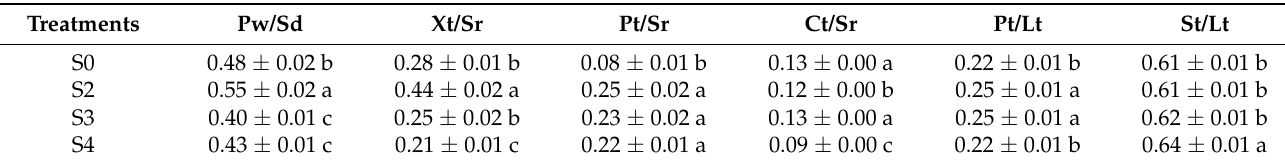
Table 6. Effects of salinity stress on the anatomical structure of organs in C. elegans seedlings. S0, S2, S3, and S4 indicate control, 0.2%, 0.3%, and 0.4% salt concentration treatments, respectively. Pw/Sd, pith width/stem diameter; Xt/Sr, xylem thickness/stem radius; Pt/Sr, phloem thickness/stem radius; Ct/Sr, cortical thickness/stem radius; Pt/Lt, palisade tissue thickness/leaf thickness; St/Lt, spongy tissue thickness/leaf thickness. Values are the mean ± standard error. Values for each column followed by different letters denote a significant difference among different treatments according to Duncan’s new multiple range test ( p < 0.05).